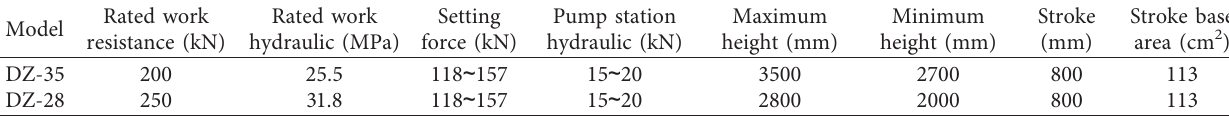
Table 2: The main technical characteristics of single hydraulic prop.